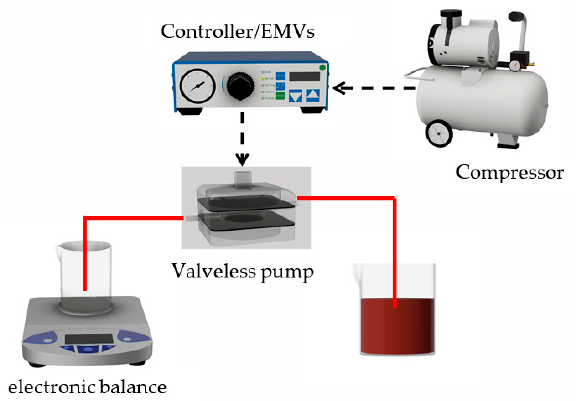
Figure 4. Schematic diagram of experimental setup.